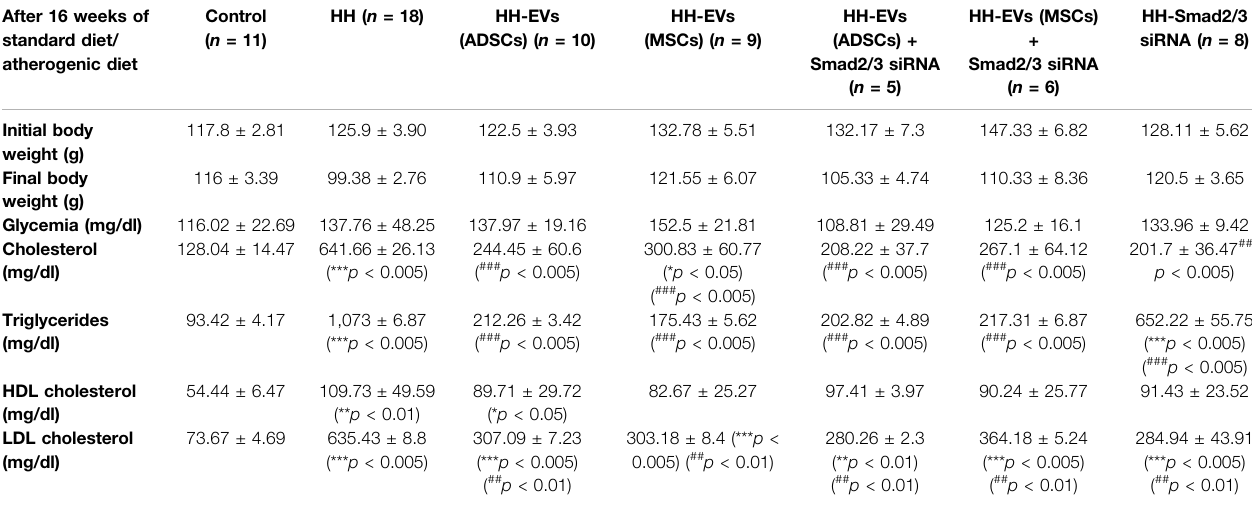
TABLE 1 | Clinical characteristics and biochemical parameters of the seven experimental animal groups, control (C); simultaneously hypertensive – hyperlipidemic (HH); HH- EVs(ADSCs), HH-EVs(MSCs), HH-EVs(ADSCs)+Smad2/3siRNA, HH-EVs(MSCs)+Smad2/3siRNA, and HH-Smad2/3 siRNA, after 16 weeks of standard diet or atherogenic diet, and at 14 weeks post-treatment with EVs (ADSCs) or EVs (MSCs) transfected or not with Smad2/3siRNA during the diet-induced atherosclerotic process. Data are means ± SD of duplicate determinations. The statistical signi fi cance, noticeably different, was represented as *** p < 0.005, ** p < 0.01, * p < 0.05 values versus control group and ### p < 0.005, ## p < 0.01, # p < 0.05 values versus HH group. Two-way ANOVA and Bonferroni post-test were